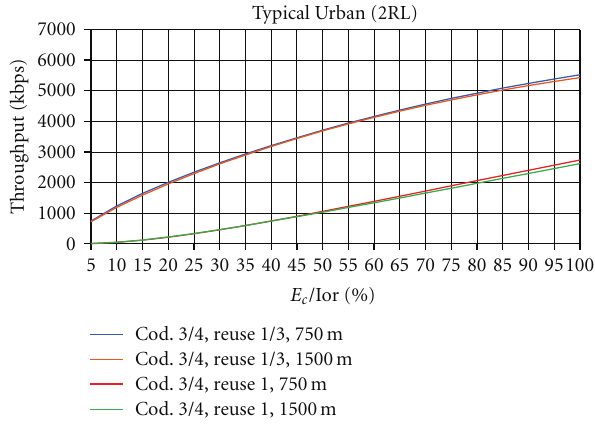
Figure 19: MIMO Throughput versus E c /Ior for SC-PTM, cod. 3 / 4.